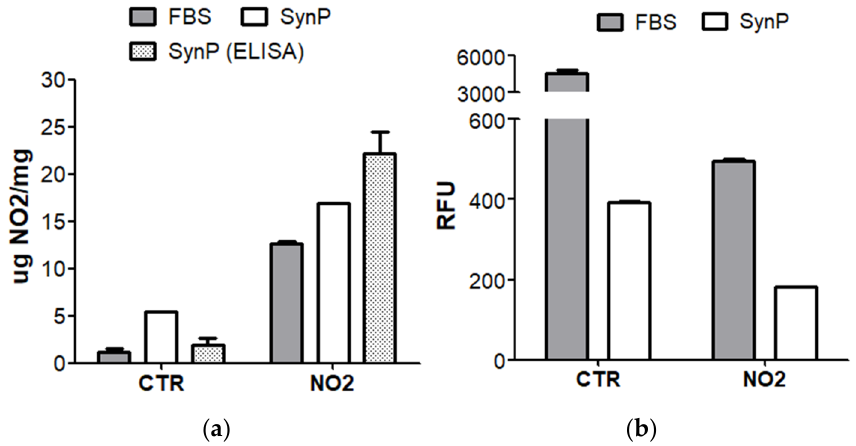
Figure A4. Assessment of NO 2 -SynP in comparison with unmodified SynP and control FBS by ( a ) absorbance and ELISA to detect 3-NT; and ( b ) fluorescence to detect unaltered tyrosine. Th bars represent the mean and SEM of at least 2 independent experiments except for the absorbance measurement that was performed once.